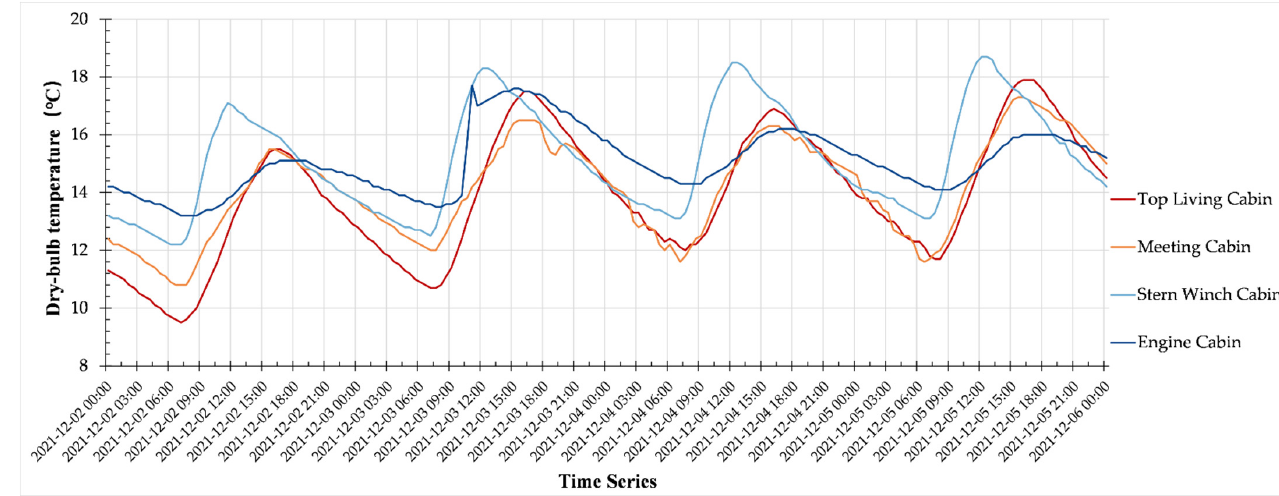
Figure 12. Dry-bulb temperatures in the ship from 2 to 5 December 2021.